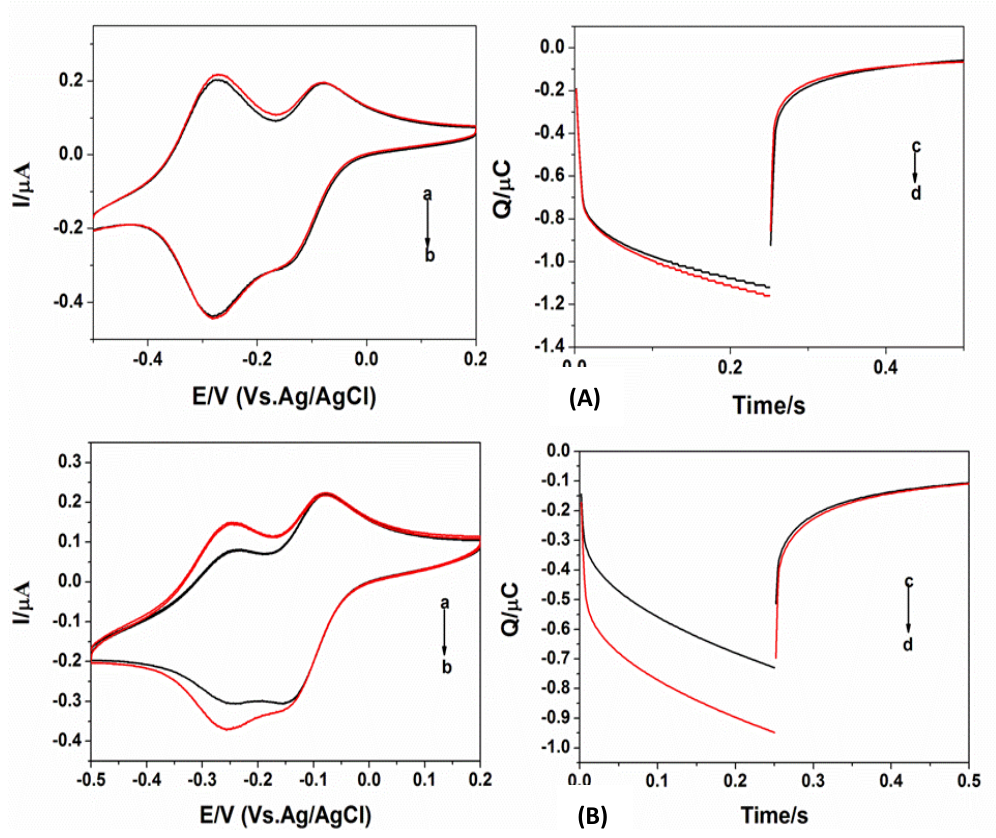
Figure 3. ( A ) Cyclic voltammograms and chronocoulometry curves of the concentration of probe is 2.0 μmol/L. Cyclic voltammograms: dsDNA/RuHex/MCH/AuE(a), ssDNA/RuHex/MCH / AuE (b), chronocoulometry curves ssDNA/RuHex/MCH/ AuE (c), ssDNA /RuHex/MCH/ AuE (d). ( B ) Cyclic voltammograms and chronocoulometry curves of the concentration of probe is 0.5 μmol/L. Cyclic voltammograms: dsDNA/RuHex/MCH/ AuE(a), ssDNA/RuHex/MCH/AuE(b), chronocoulometry curves: ssDNA/RuHex/MCH/ AuE (c), ssDNA /RuHex/MCH /